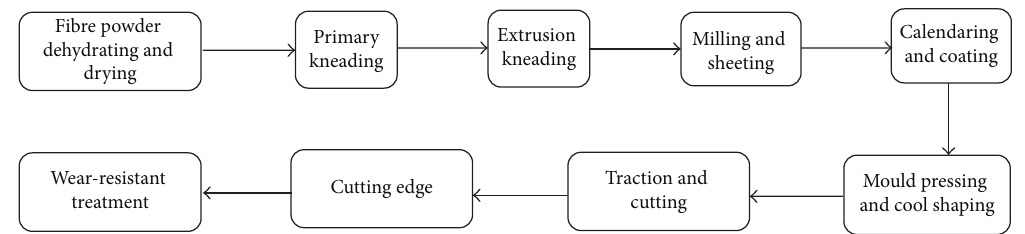
Figure 2: Wood floor and wooden fiber homogeneity hollow coiling molding